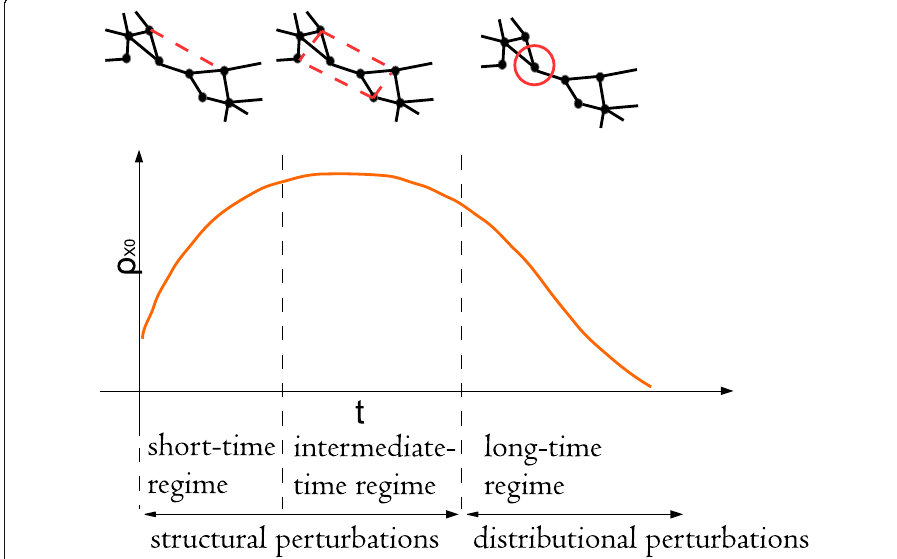
Fig. 9 The schematic representation of the short-time, intermediate-time and long-time regimes of the FPT density on various